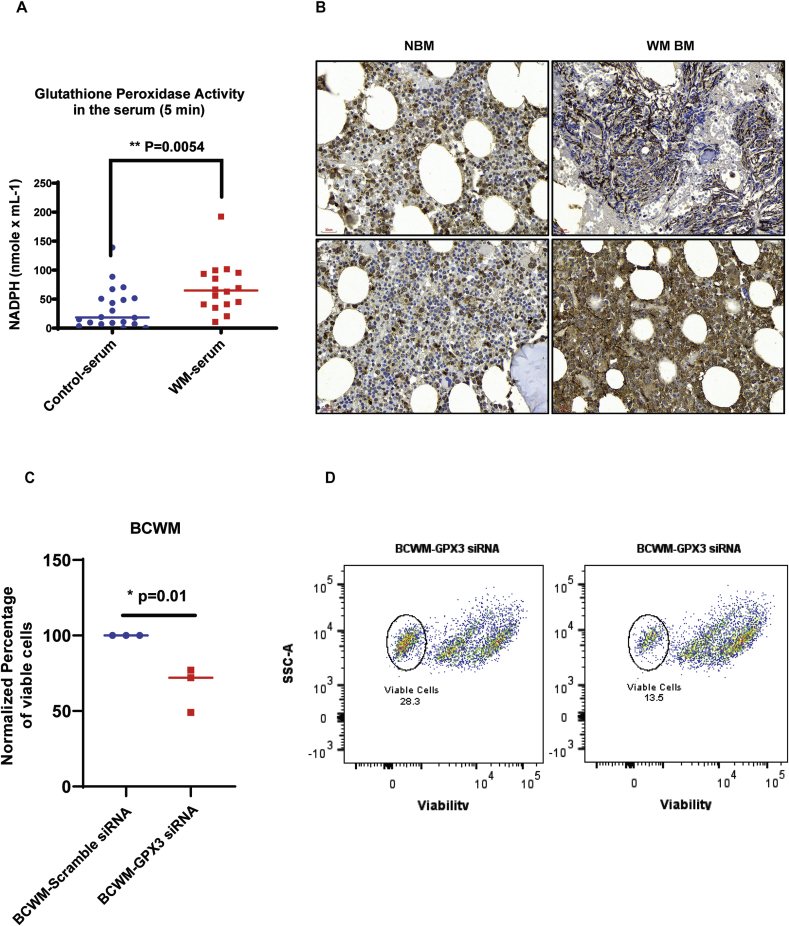
Increased glutathione peroxidase expression and activity in the WM samples, as compared to the normal equivalents. A) Bar graph compares the total GPX activity in the serum of the WM patients (n = 16) and normal donors (n = 20). B) IHC analysis of the BM tissue samples from WM patients and normal donors shows the pattern of GPX3 staining. Upper panel and Lower panel belong to two different WM and Normal BM samples. C) Dot plot represents normalized viable BCWM.1 cells transfected with either scrambled or GPX3 siRNA (n = 3). D) Flow cytometry analysis of the scrambled or GPX3 siRNA transfected BCWM.1 cell lines showing reduced cell viability following GPX3 siRNA transfection. The figure is the representative of three independent experiments.